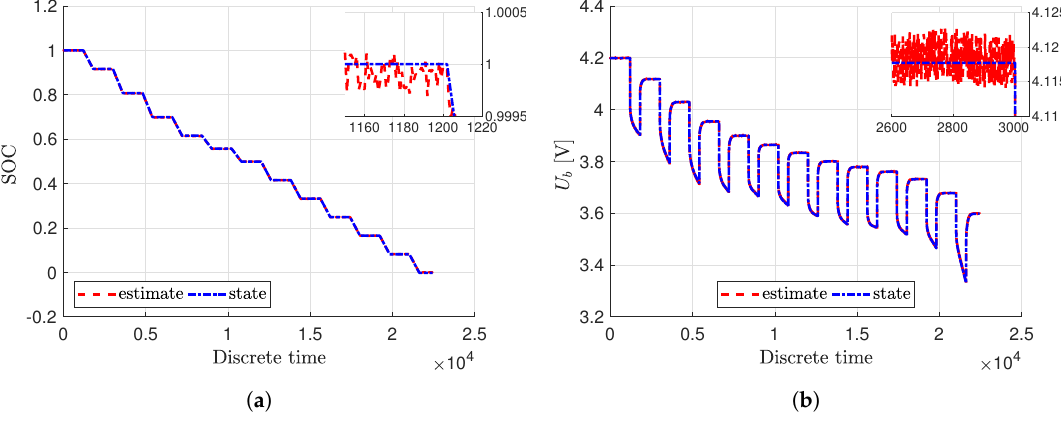
Figure 5. State variable U soc ( a ) and battery voltage U b ( b ).